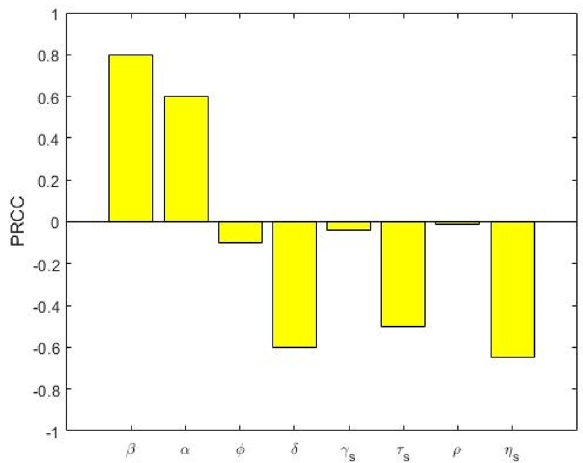
Figure 3. PRCC values depicting the sensitivity of the drug-susceptible basic reproduction number R 0s with respect to the parameters β , α , φ , δ , γ s , τ s , ρ and η s .